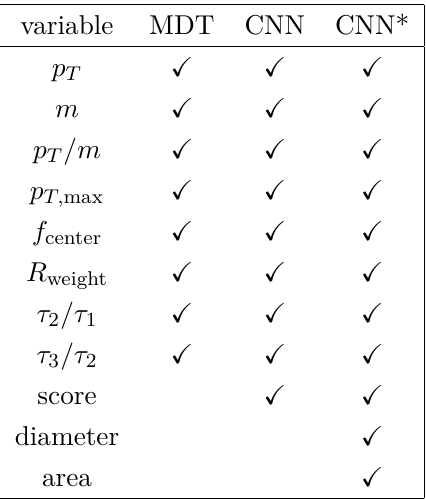
Table 2. Variables that are adopted in the BDT analyses. The definitions for those variables can be found in the text.